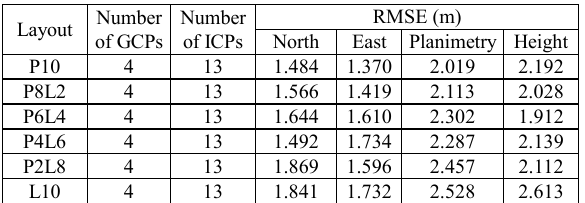
Table 5. Block adjustment accuracy of the ZY-3 TLC images in the dataset 2.